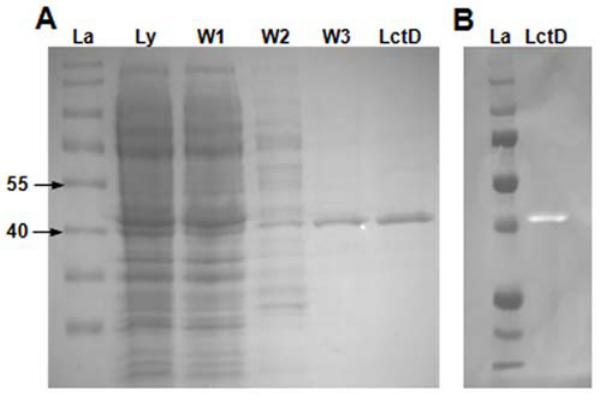
Figure 3. Purification of LctD-his 6 . (A) SDS-PAGE analysis of LctD-